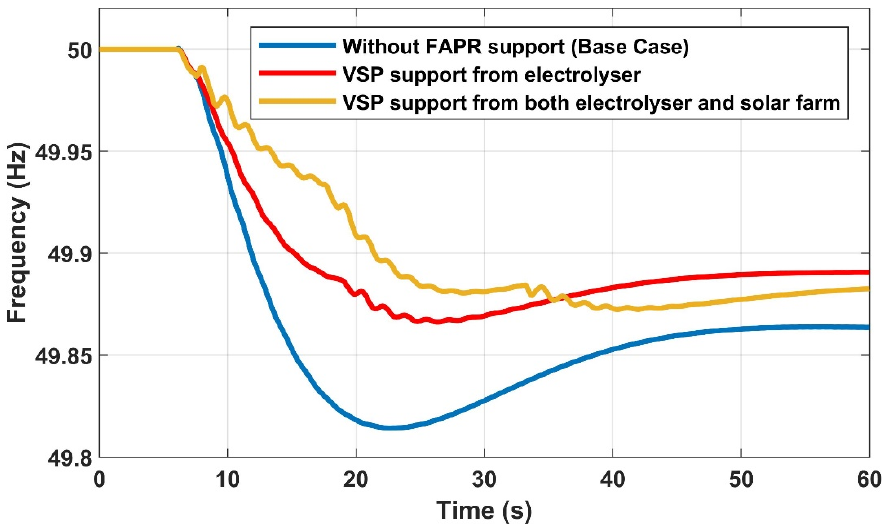
Figure 11. Frequency comparison plots in renewable energy system conclusions.